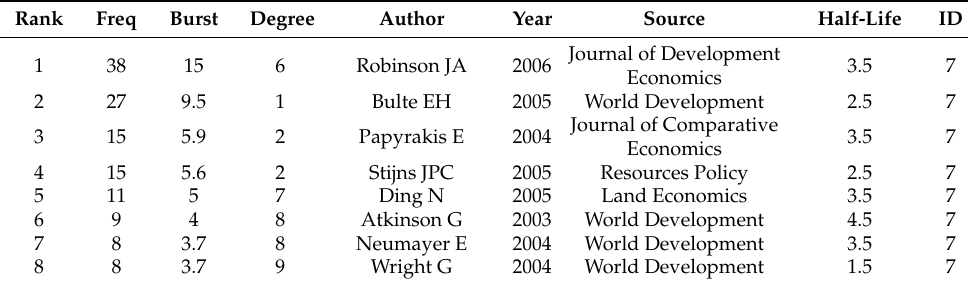
Table A7. Cluster 7 high-impact members.